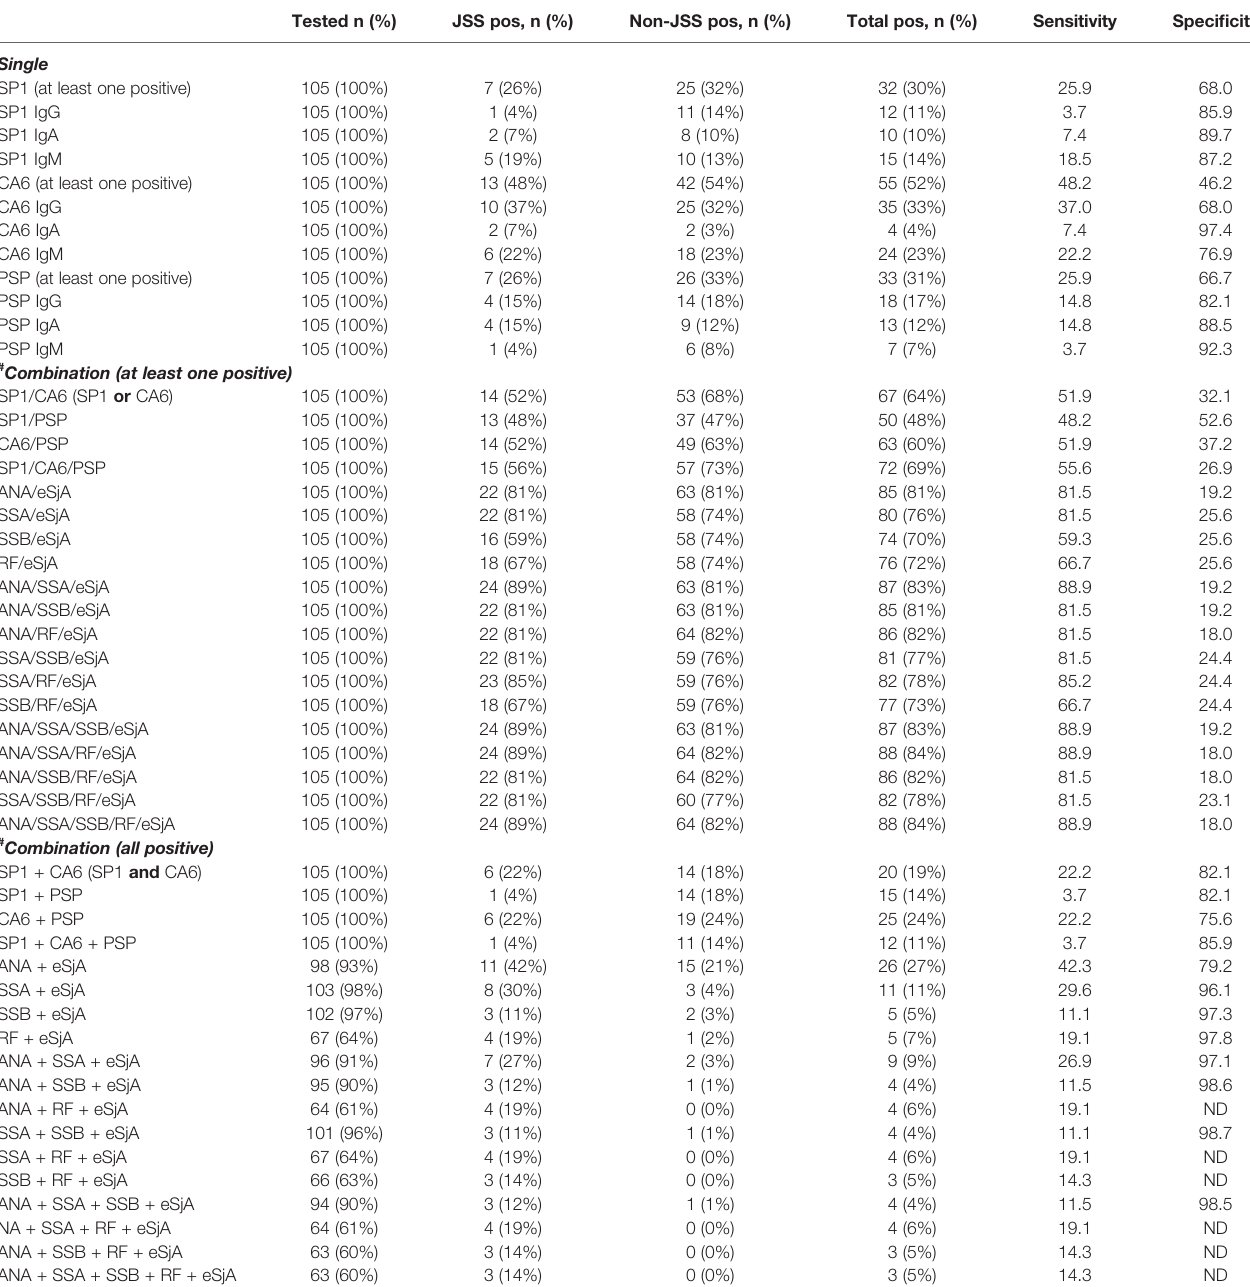
TABLE 3 | Diagnostic performance of eSjA for JSS